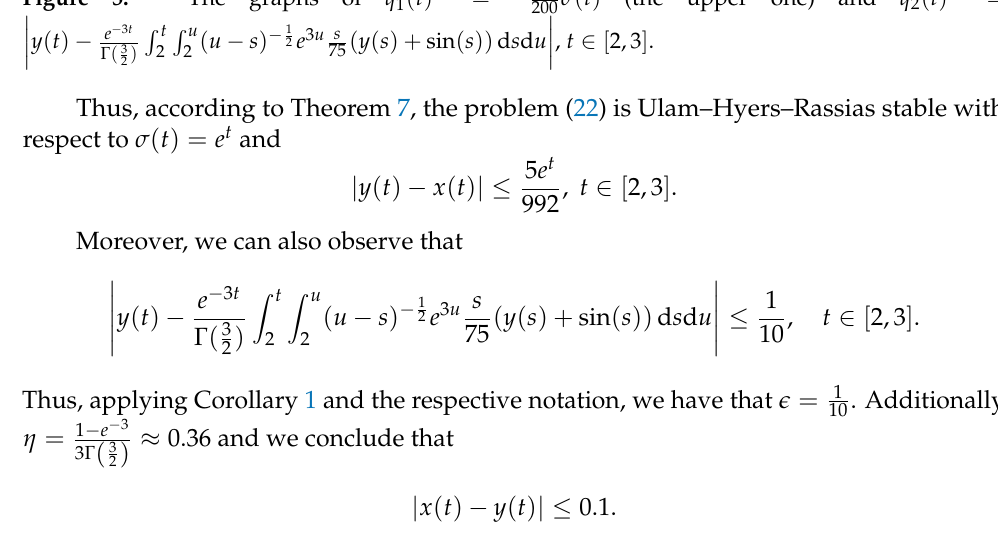
σ ( t ) (the upper one) and q 2 ( t ) = 200 (cid:12) (cid:12) , t ∈ [ 2,3 ] (cid:12) (cid:12)